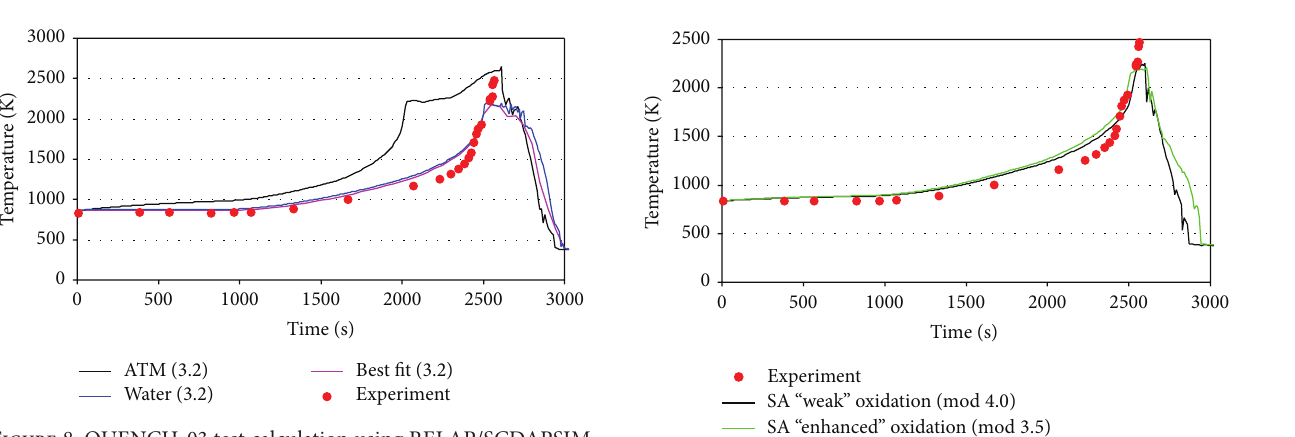
Figure 10: QUENCH-03 test calculation using RELAP/SCDAPSIM mod 4.0 and mod 3.5. The second approach of heat generation in “Cora” description. Fuel rod imitator cladding outer surface temperature in outer ring of bundle at 750 mm height.